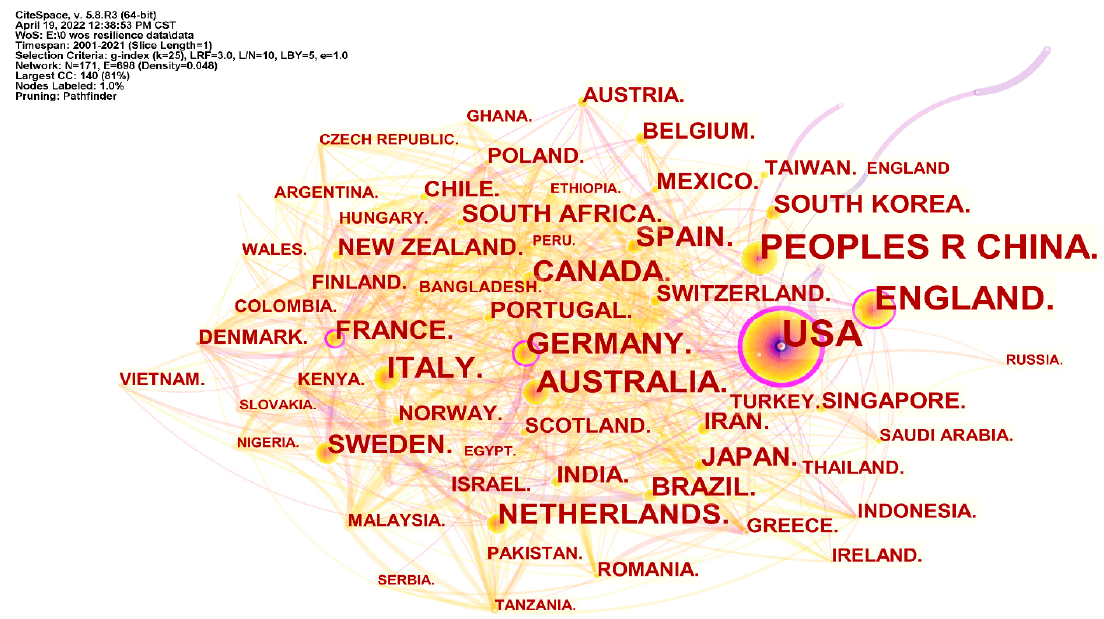
Figure 2. Collaborative co-occurrence map of RC regional cooperation distributions.